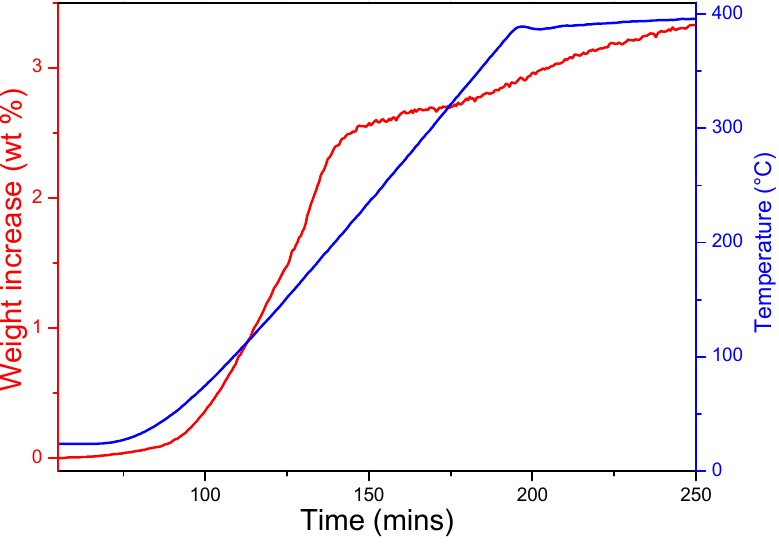
Figure 1. Hydrogen uptake of as-milled Na 2 O under 18 bar of